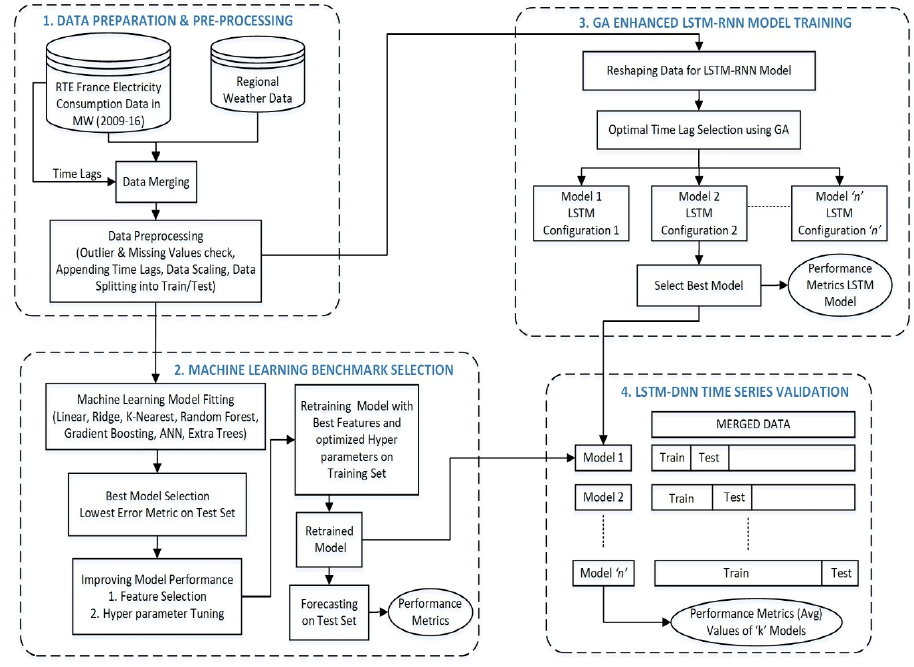
Figure 3. Proposed forecasting methodology.